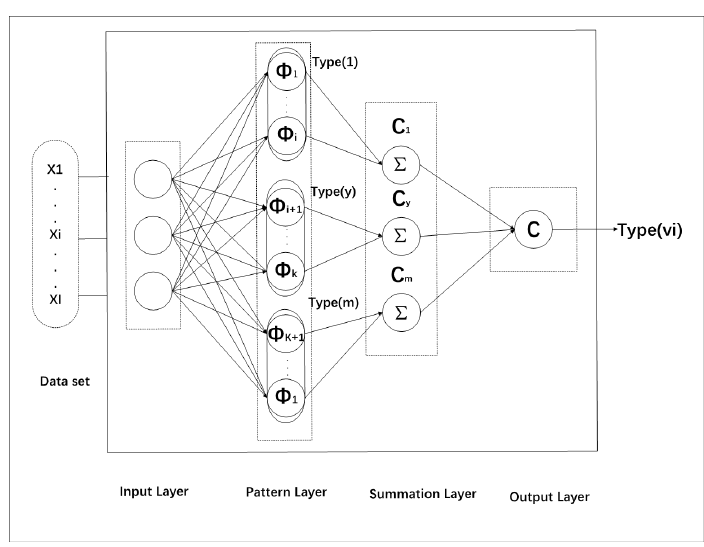
Figure 2. The structure of